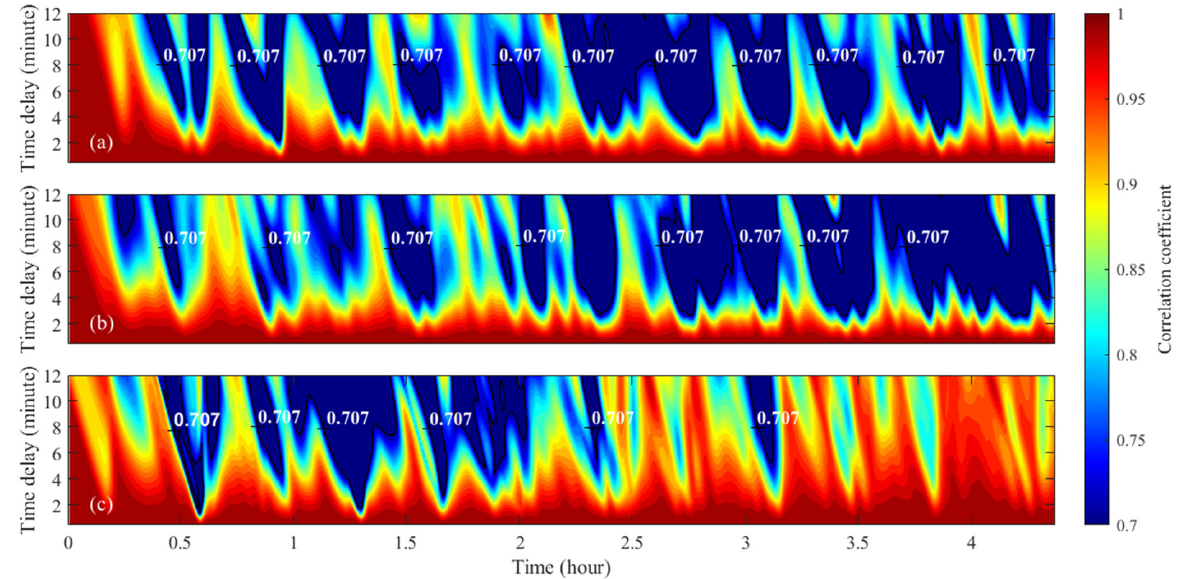
Figure 6. Contour plots of simulated correlation coefficients vs. time and time delay at the range of 14.8 km in the ideal ISWs environment at three different depths: ( a ) 12 m, ( b ) 31 m, and ( c ) 92 m. To show the periodical characteristics of 𝐶(cid:4666)𝑡 , 𝑡 (cid:3397) 𝜏(cid:4667) more clearly, the temporal cor ‐ relation coefficient spectrum 𝑄 (cid:3004) (cid:4666)𝜏(cid:4667) with a fixed time delay 𝜏 can be obtained by